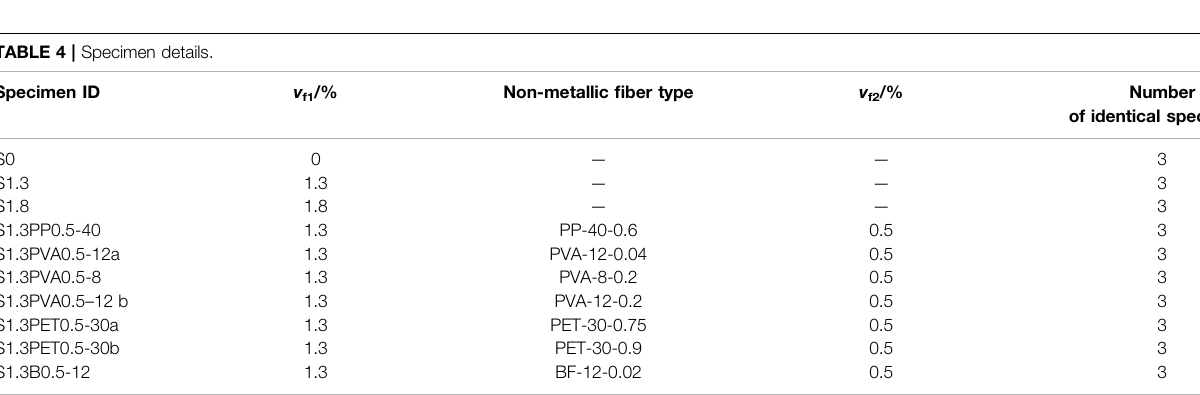
Table 3 . Referring to the Chinese standard: technical speci fi cation for fi ber-reinforced concrete structures (CECS 38:2004) (CECS 38:2004, 2004), it was considered that a fi ber diameter less than